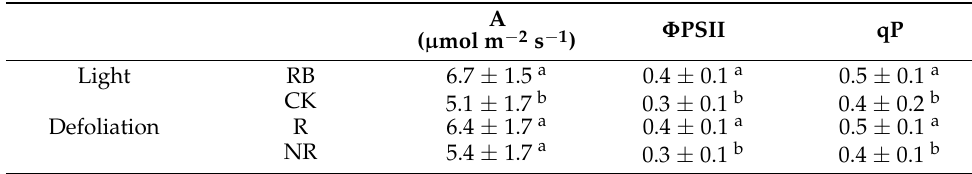
Table 2. Effects of the two separated factors, light (supplemental red and blue LED light, RB, and natural light, CK) and defoliation (early leaf removal, R, and no-removal, NR), on net photosynthesis (A), effective quantum yield efficiency of PSII ( Φ PSII) and photochemical quenching of PSII (qP). Different letters indicate significant differences at ANOVA (significant level p ≤